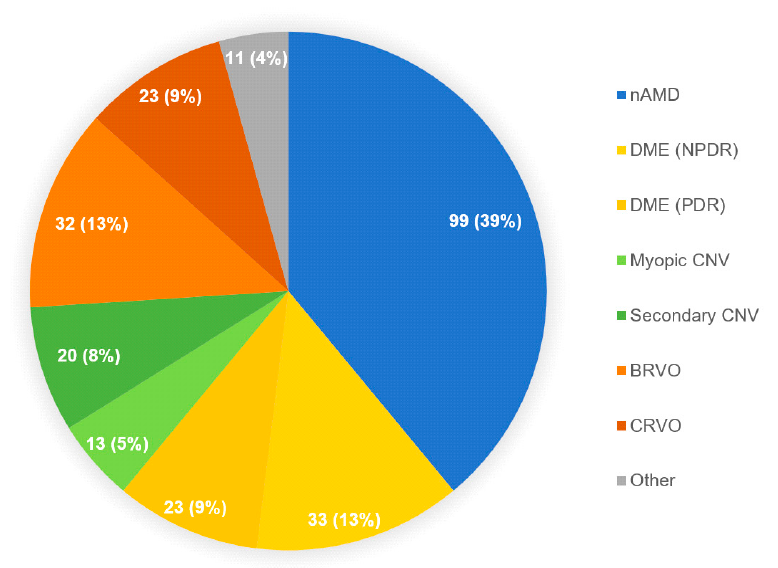
Figure 2. Primary ophthalmic diseases of the interviewed study participants. The graph shows the number of patients in each group followed by its percentage among all primary ophthalmic dis-